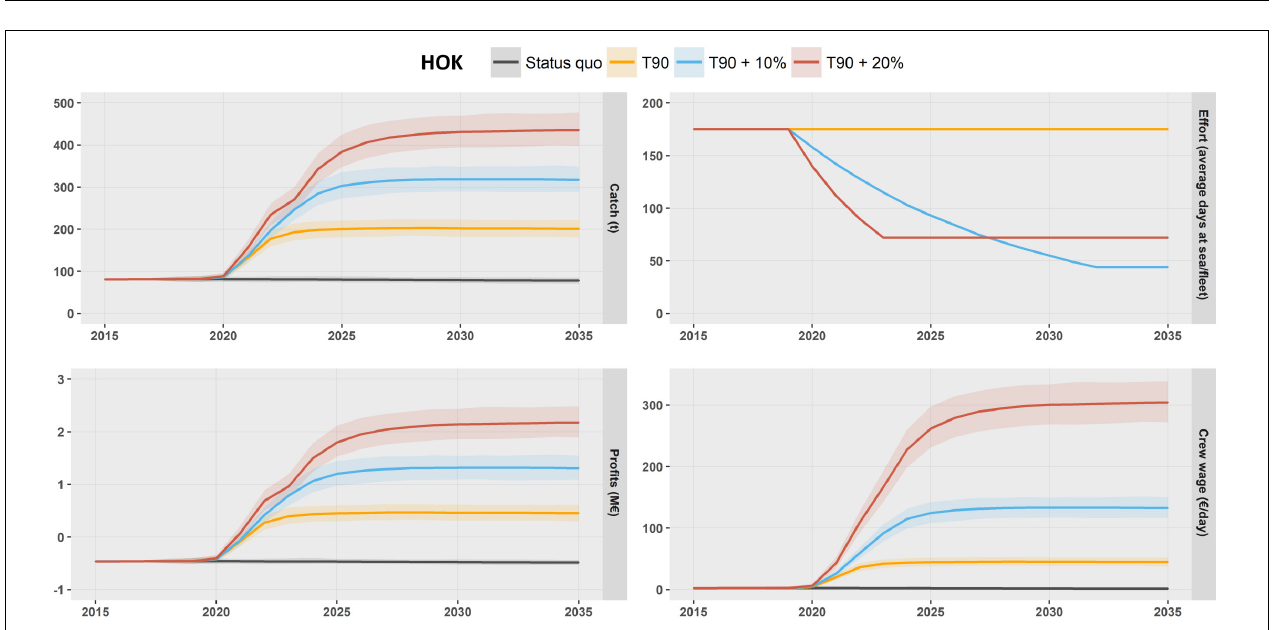
FIGURE 7 | Results of the bioeconomic model of catch (t), effort (average days at sea), profits (M€), and crew wage (€/day) for the trawler fleet (OTB) under Scenario 0: status quo ; Scenario 3: selectivity change to T90; Scenario 4: selectivity change plus 10% annual reduction over 4 years; and Scenario 5: selectivity change plus 20% annual reduction over 4 years.